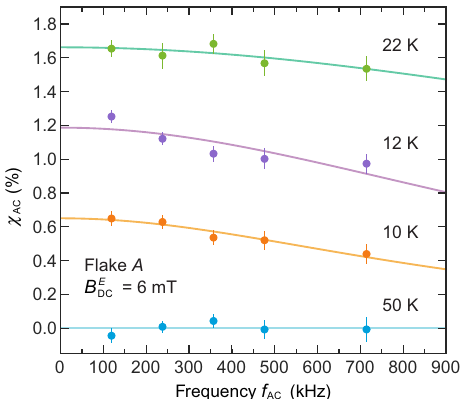
FIG. 5. Frequency-dependent susceptibility of domain walls in ultrathin CrBr 3 . The susceptibility χ ac for Flake A at 50 K (blue), 22 K (green), 12 K (purple), and 10 K (orange) during FC. The solid lines are fits using a damped, driven domain wall oscilla- tion model. The number of π pulses increases for larger f ac (e.g., XY8- N 6 is used for 714